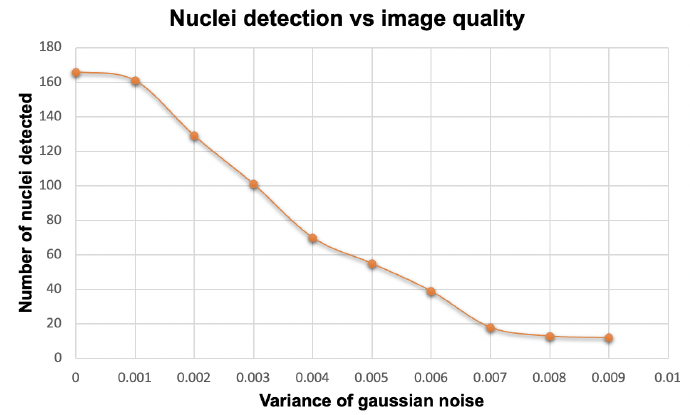
Figure 5. Effect of image quality on the nuclei detection